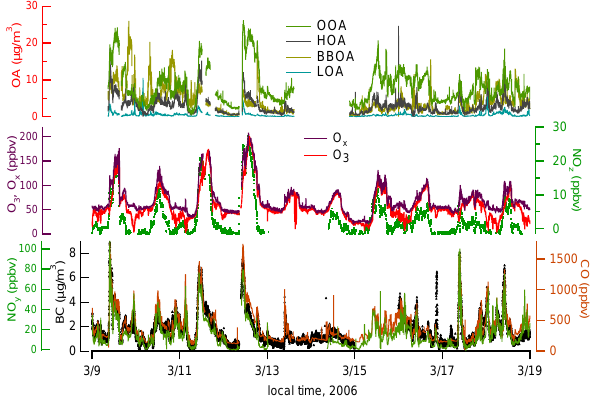
Fig. 1. Time series of OOA, O x , and other species at Pico de Tres Padres. Gaps are from instrument maintenance.